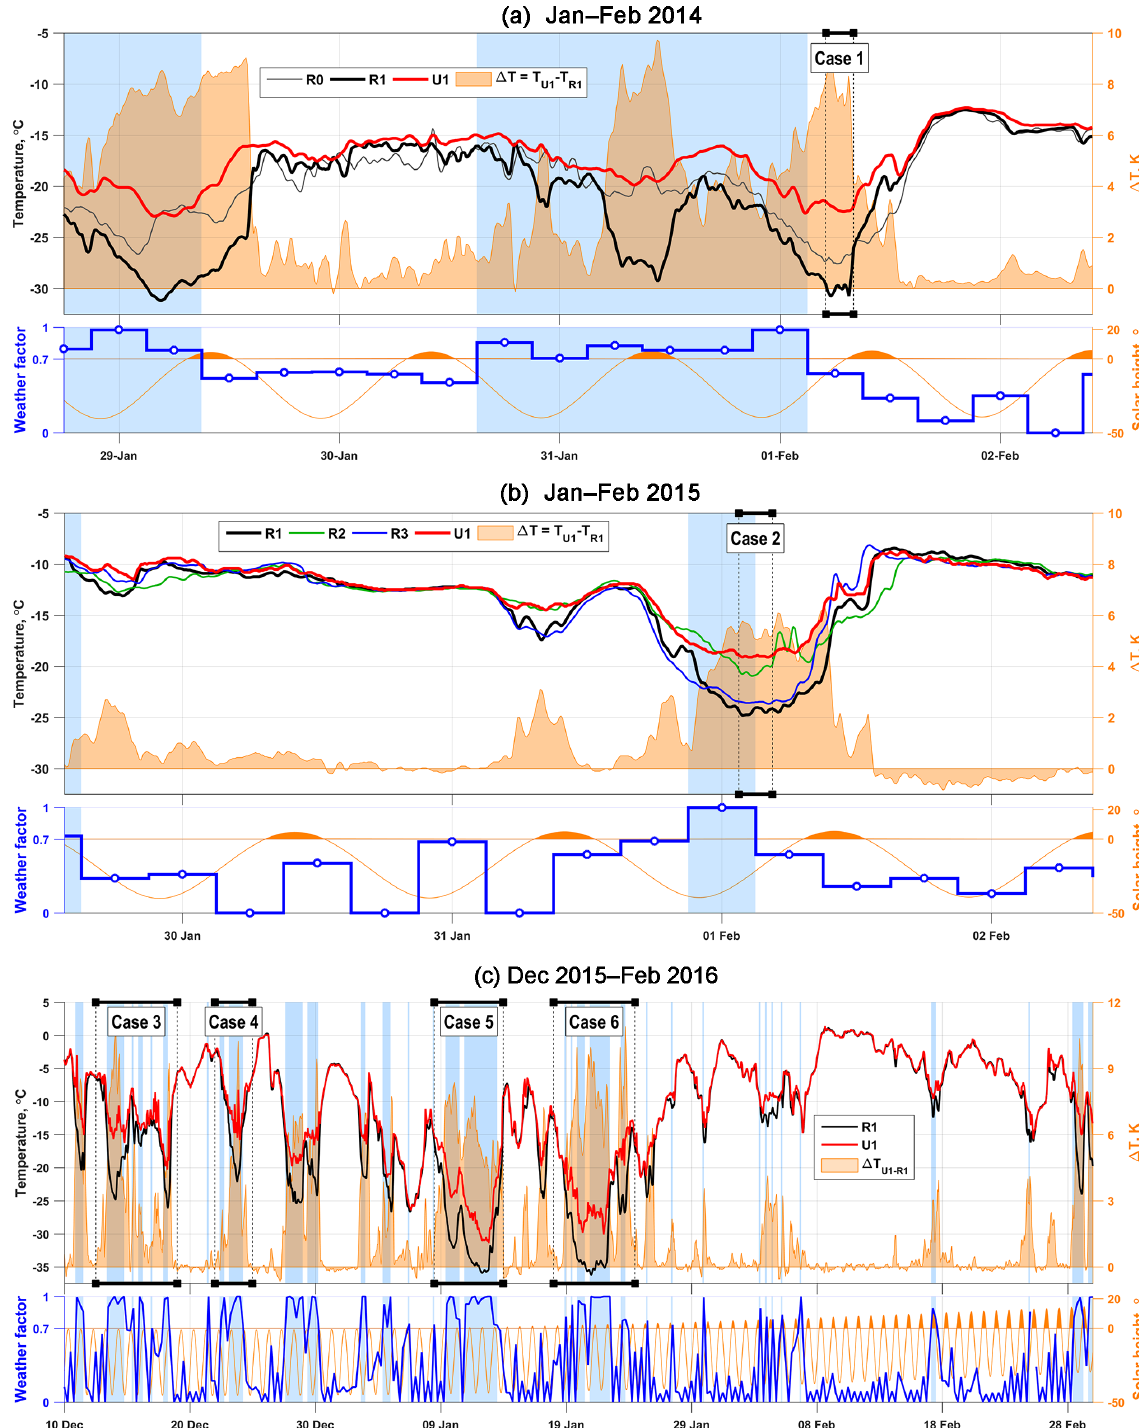
Figure 3. Observations of the surface air temperature in the city center (the red line for the U1 station) and the rural sites outside the city (the black, blue and green lines) in the (a) 2014 and (b) 2015 winters and (c) the longer observations in the winter 2015–2016. The UHI magnitude (area shaded in orange) is defined as (cid:49) T U1 . For the 2014 and 2015 data, 30min running means are shown, whereas 3h running R1 means are shown for the longer experiment over the 2015–2016 period. The six case study periods indicated in black were selected for further study (see Figs. 4 and S4). The weather factor W f (the blue line on the lower panel) was calculated from observations at R1 using 6-hourly data. The solar angle is indicated by the orange line with shading indicating the periods with positive values. The light blue shading indicates the anticyclonic weather periods with W f >0.7. The geographical locations of the stations are shown in Fig.